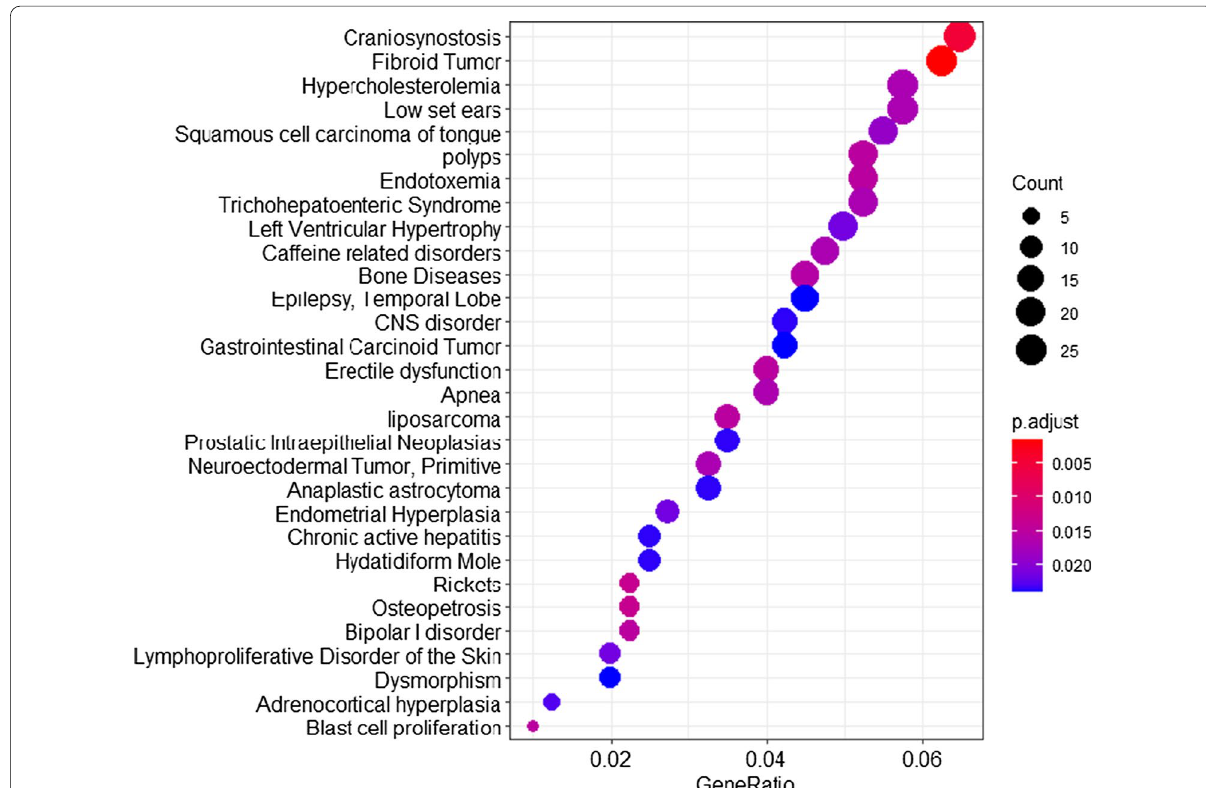
Fig. 8 Over‑representation analysis of the most significantly differentially expressed genes ( p < 0.05). The size of the circle corresponds with the number of genes that are mapped to a biological process, while a redder color indicates increased